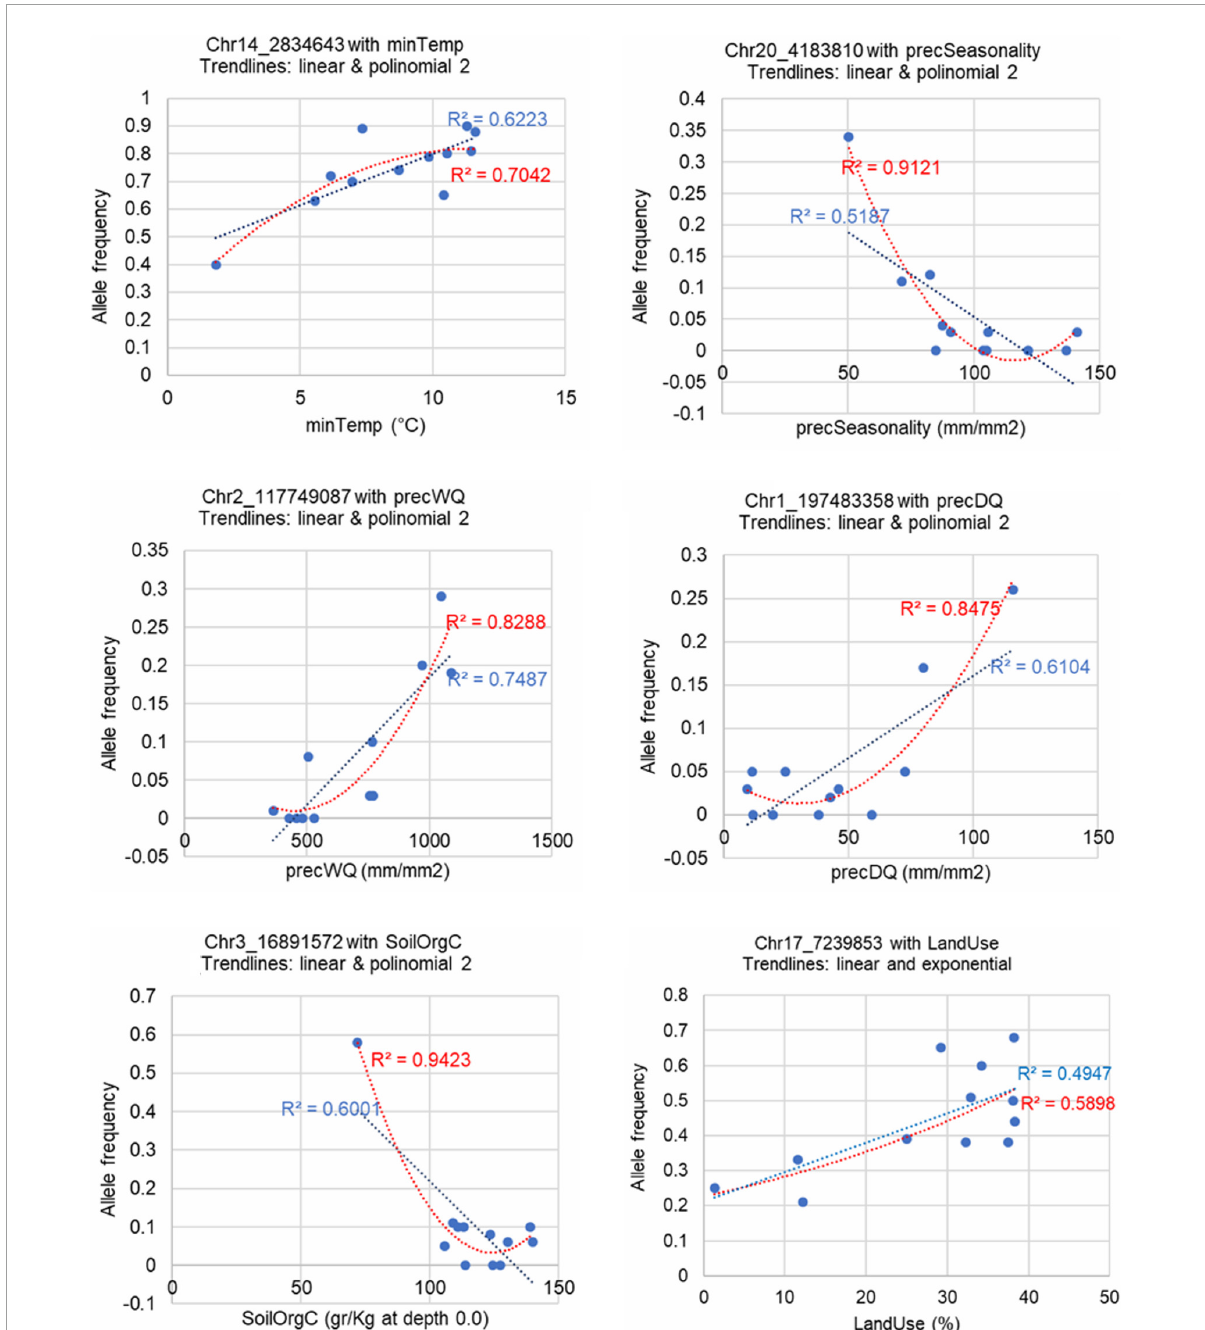
FIGURE8 Allele frequency fluctuation of example RDA outliers with agro-climatic predictors (mean value) across ecotypes. One outlier (with the strongest RDA r -value) per predictor is shown as an example.